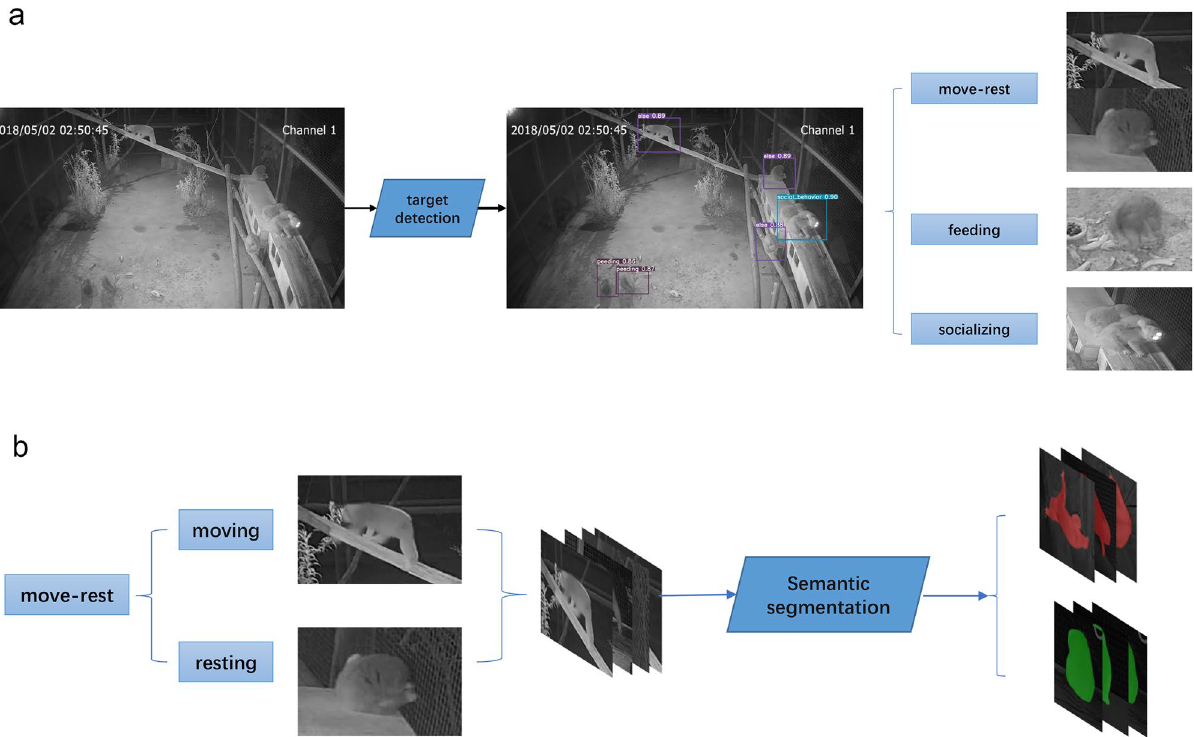
Figure 1. Processing of target detection, semantic segmentation and